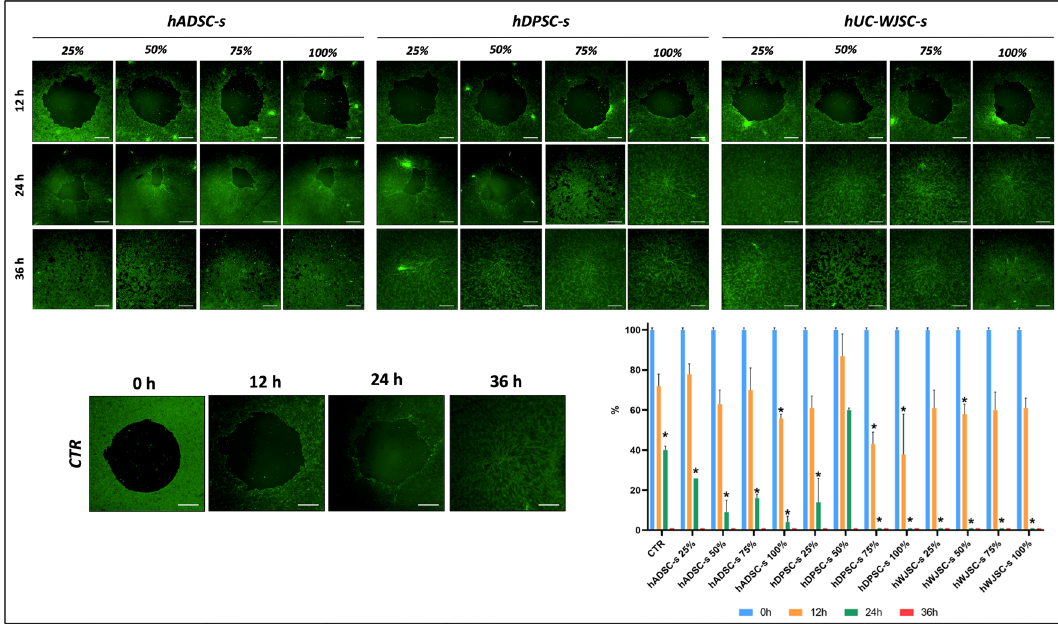
Figure 5. Results of wound healing fluorescent analysis of HSEC exposed to different types (hADSC-s, hDPSC-s and hWJSC-s) and concentrations (25%, 50%, 75%, 100%) of secretome after 12, 24 and 36 h of follow-up. CTR control group, hADSC-s human adipose-derived MSC secretome, hDPSC-s human dental pulp MSC secretome, hWJSC-s Wharton’s jelly MSC secretome. Scale bar: 100 μm. The histogram illustrates the results of quantification of the empty areas on each culture surface, normalized to the area at time zero (t0). Asterisks indicate statistically significant differences compared to controls analyzed at the same follow-up time.